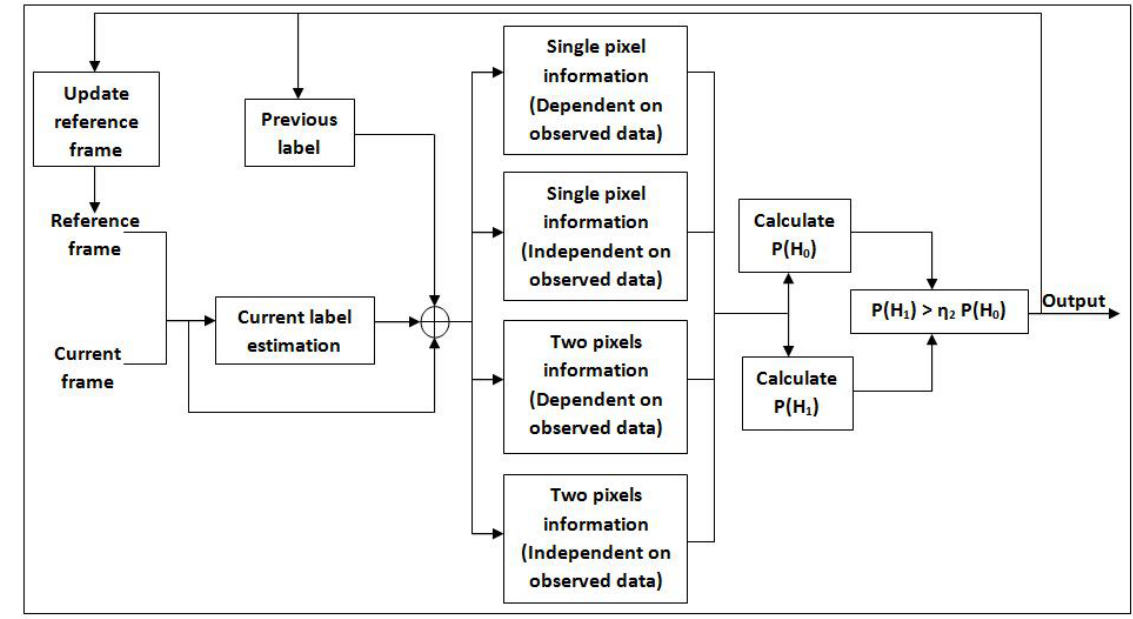
Figure 6. Block diagram of extended CRF shadow & afterimage removal